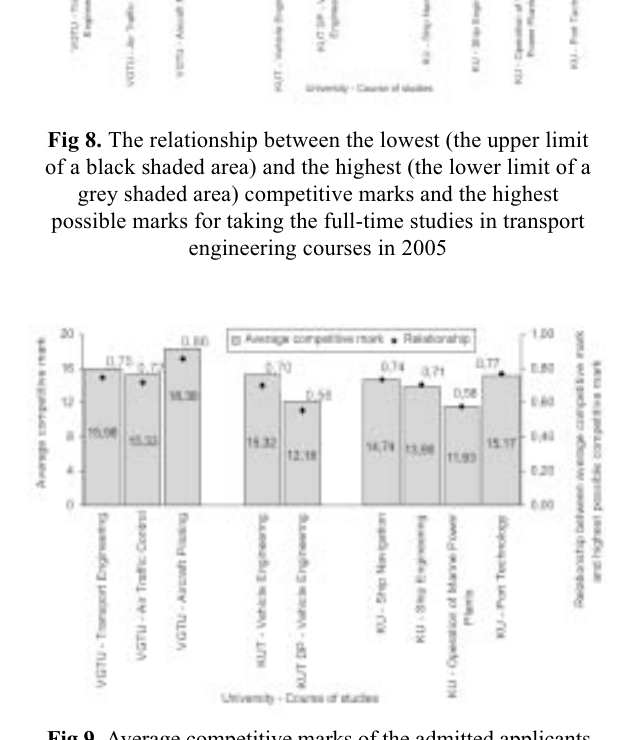
Fig 9. Average competitive marks of the admitted applicants and their relationship with the highest possible competitive mark for taking transport engineering courses in 2005